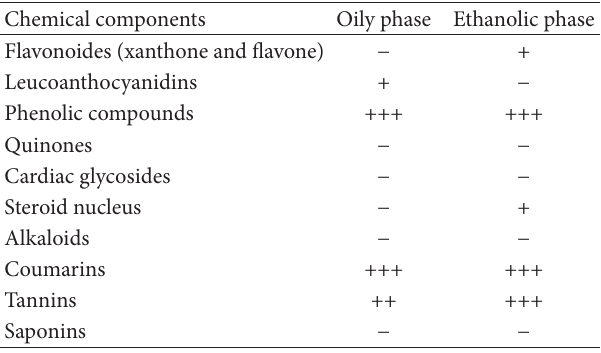
Table 2: Phytochemical screening of the oily and ethanolic phases. Chemical